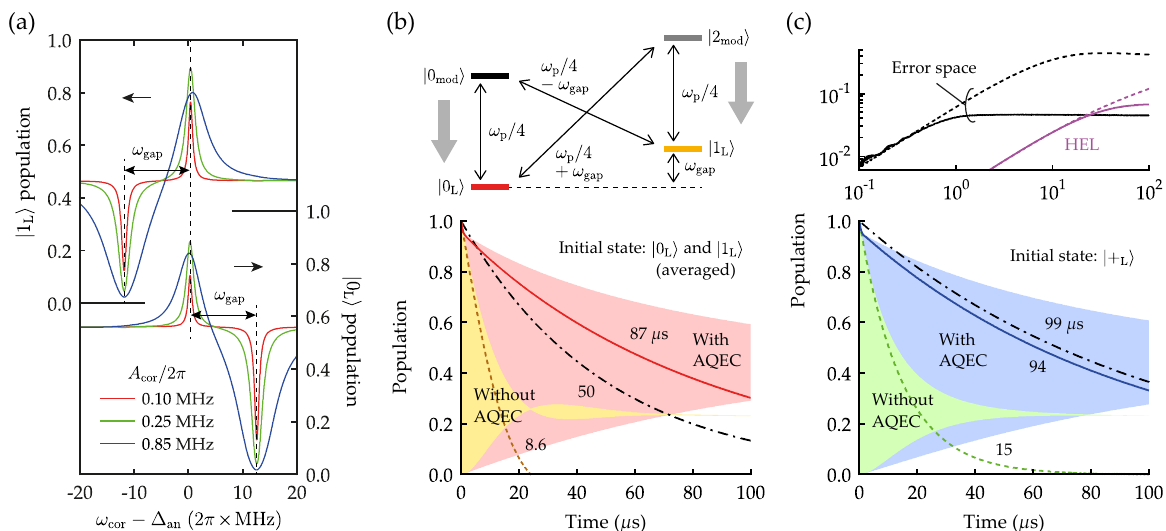
Fig. 2 Autonomous error correction. a Population of the logical qubit states as a function of ω cor after 10 μ s of evolution with various A cor . The distance between the peak and the dip is ω gap , which is found to be 12.2 MHz. b Lower panel: Bit- fl ip process of the logical qubit states with and without AQEC. The upper (lower) envelop of the shaded area is the population of the initial logical state (the orthogonal logical state). The red solid and brown dashed lines indicate the population difference between the upper and lower envelops with and without AQEC, respectively. The number near each curve indicates the corresponding bit- fl ip time extracted from exponential fi tting. The black dash- dot line indicates the longitudinal relaxation in the 0 j i and 1 j i encoding. Upper panel: Frequencies of the microwave tone (not the energy levels) at which transitions are induced among the four eigenstates. The thick gray arrows constitute a graphical summary of our AQEC scheme. c Lower panel: Phase- fl ip process of the logical qubit states with and without AQEC. The number near each curve indicates the corresponding phase- fl ip time. The black dash-dot line indicates the transverse relaxation in the 0 j i and 1 j i encoding. Other initial states, (cid:2) L j i